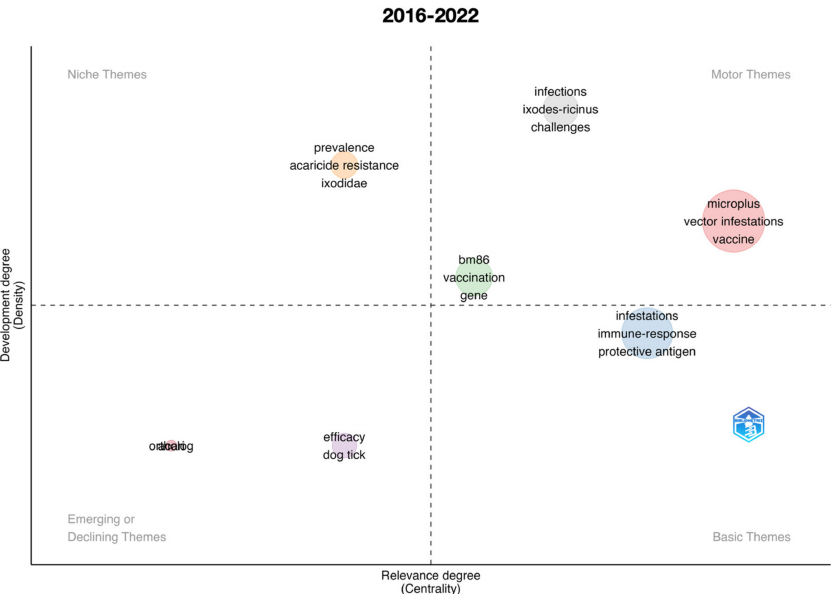
Figure 5. Thematic roles of the documents published on the topic “anti–tick vaccination” in the period 2009–2015.